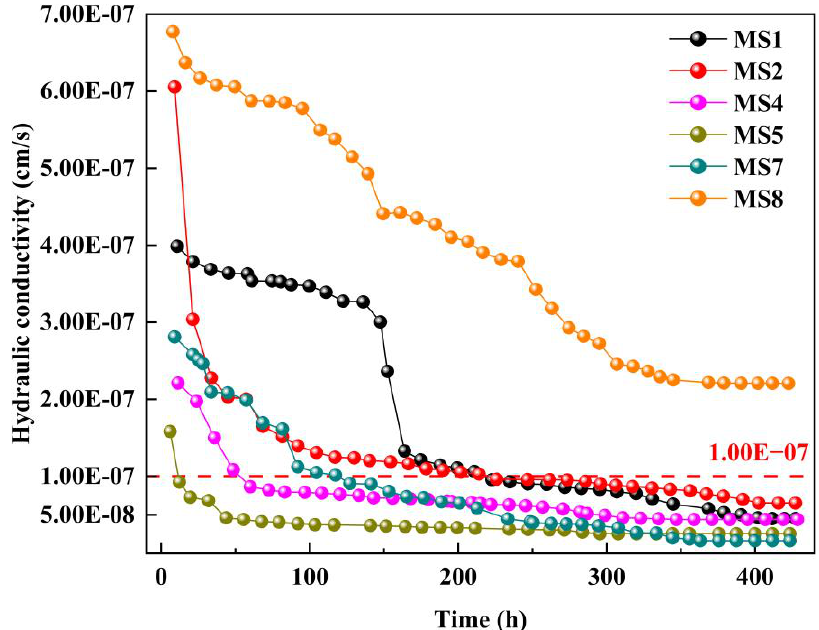
Figure 4. Hydraulic conductivity of solidified sludge samples.